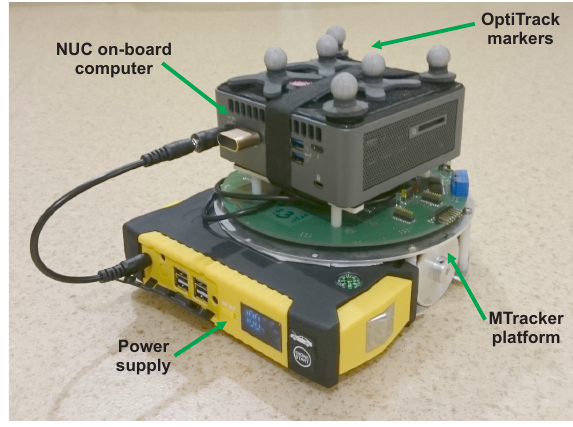
Figure 4. MTracker mobile robot with